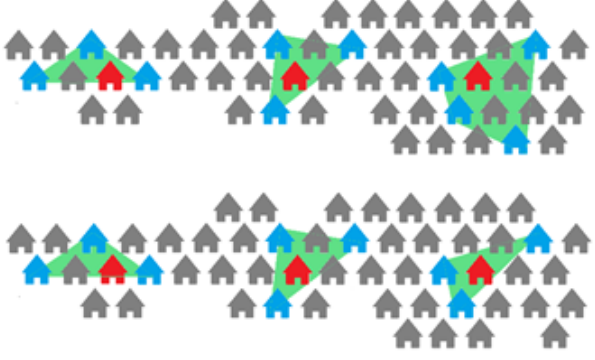
Figure 5. Coverage of subjects after application of Filter 2.